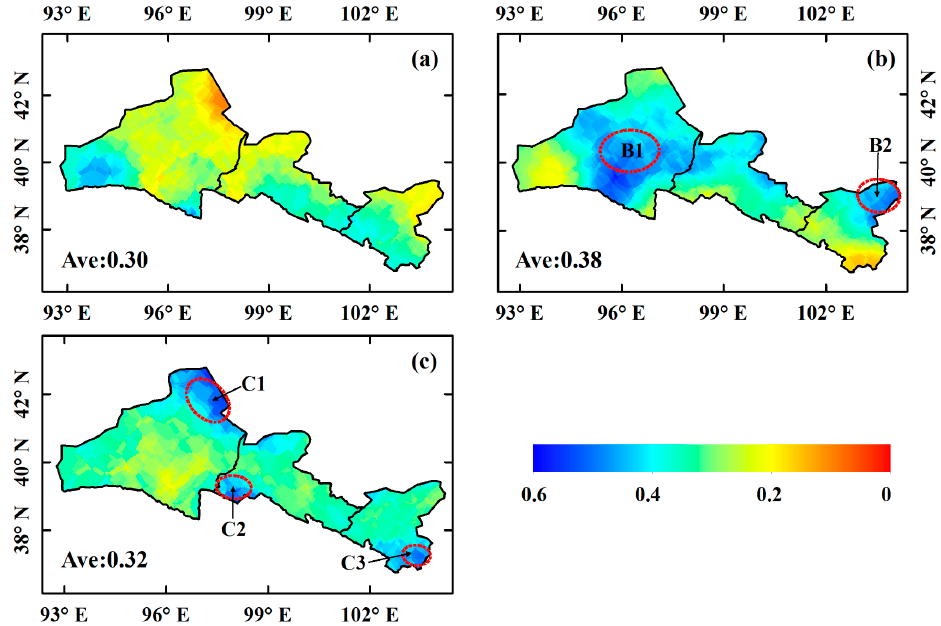
Figure 13. Weights of three GRACE-based GWSA for the fused GWSA. ( a ) GRACE − GLDAS; ( b ) GRACE − ERA5; ( c ) GRACE − WGHM.